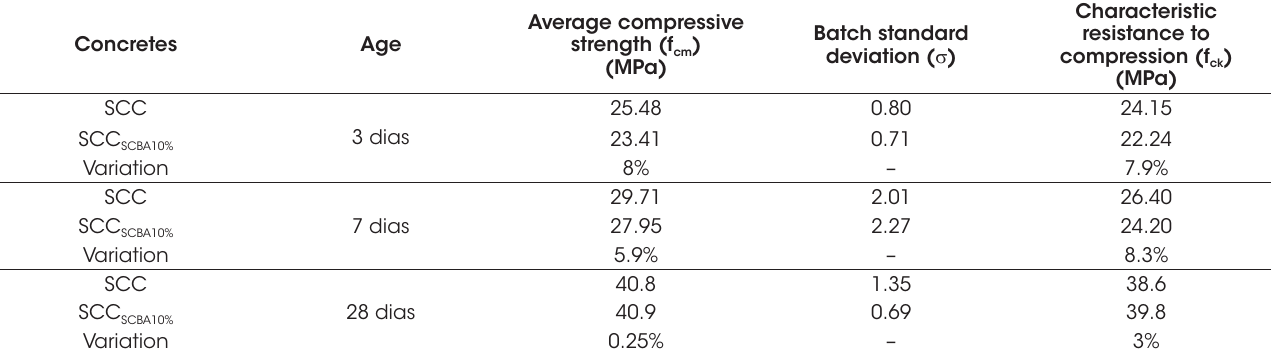
Axial compressive strengths at 3, 7 and 28 days